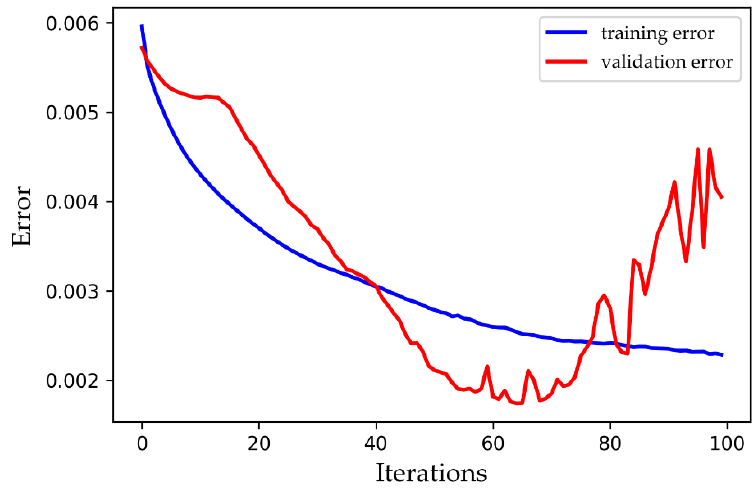
Figure 3. An example of overfitting.